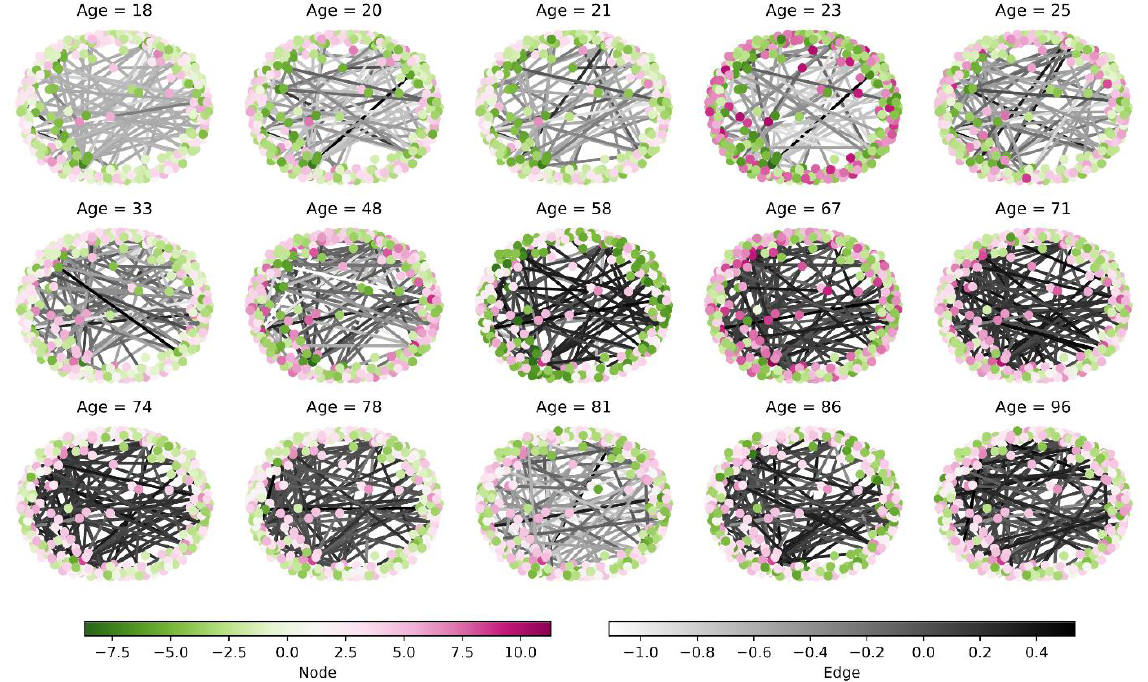
Figure 10. Dynamic network of SHAP interaction values. The individual networks are arranged in increasing order of age, with the top of the network identifying its age. The two color bars at the bottom of the figure identify the magnitude of the SHAP values of the nodes and edges respectively.